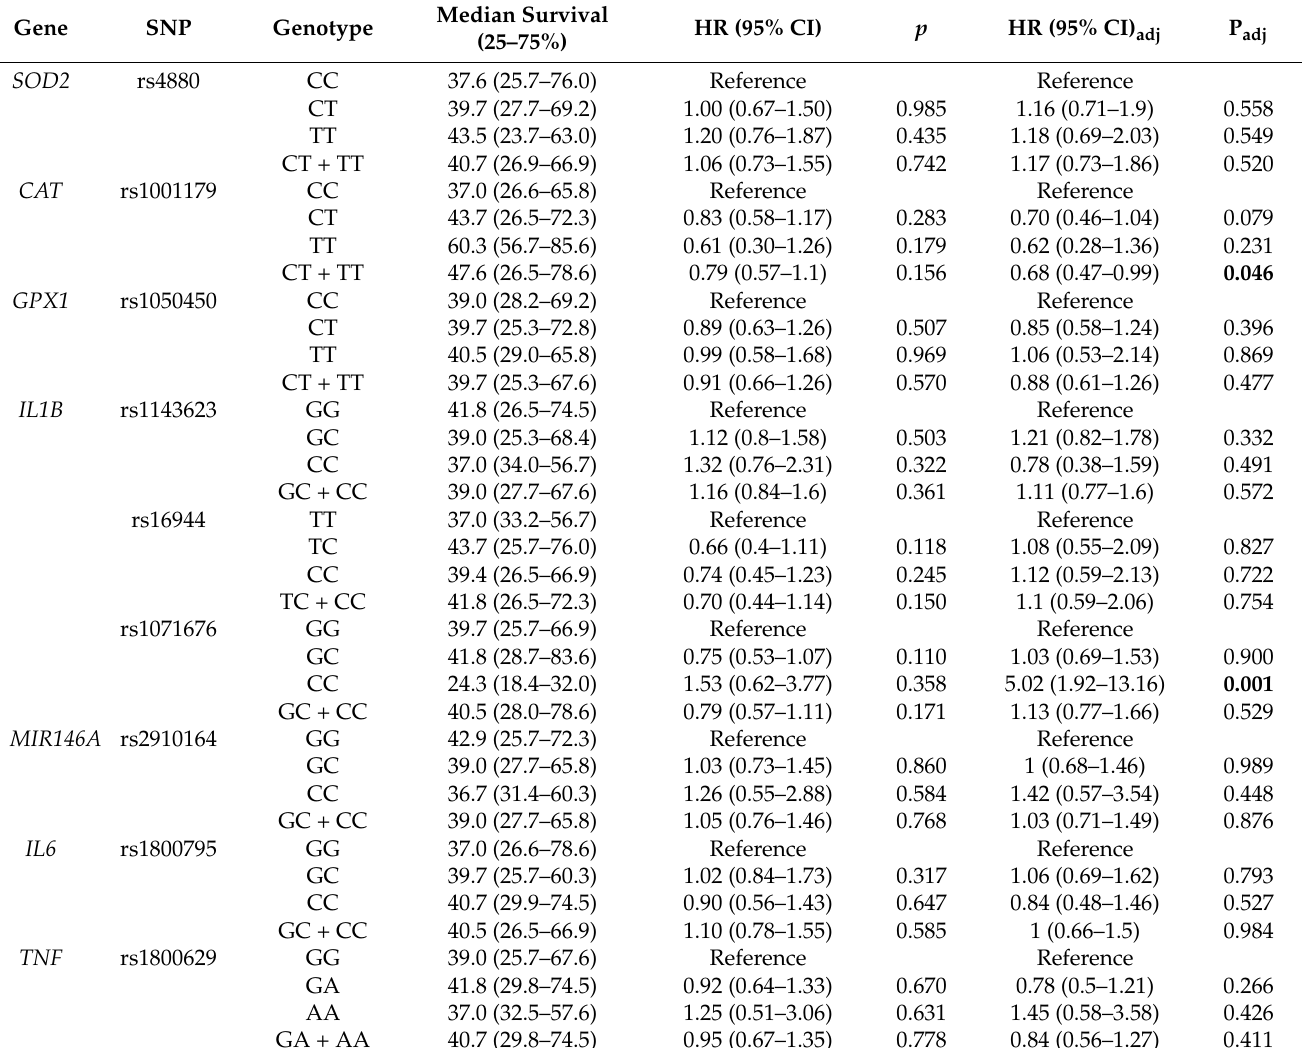
Adj: adjusted for age at onset and rate of disease progression. The bold represents statistical